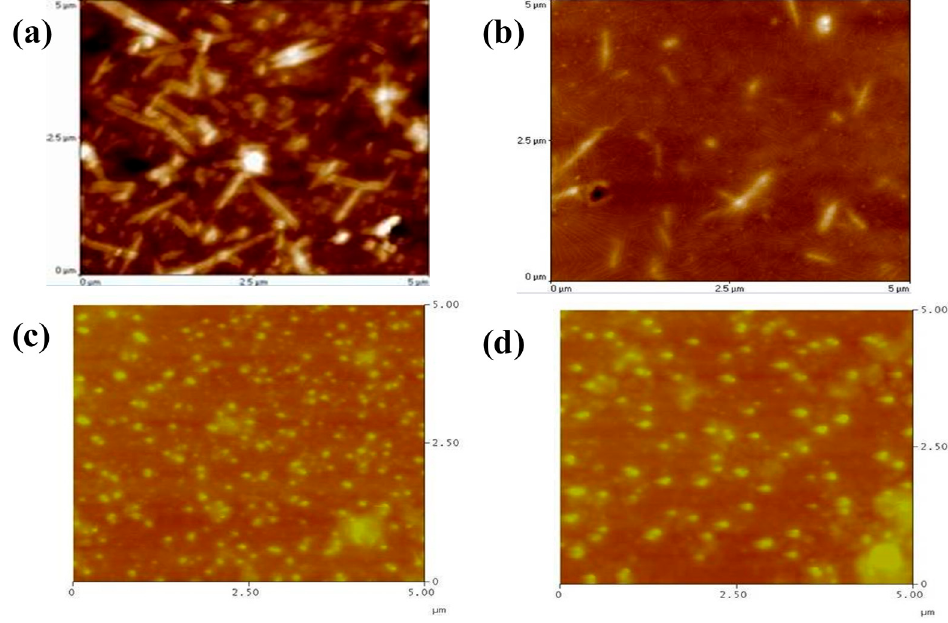
Figure 5. AFM images of POF 10 – b– PDPAEMA 90 aggregates in water at temperatures of ( a ) 30 °C, ( b ) 50 °C, ( c ) 60 °C, ( d ) 80 °C.